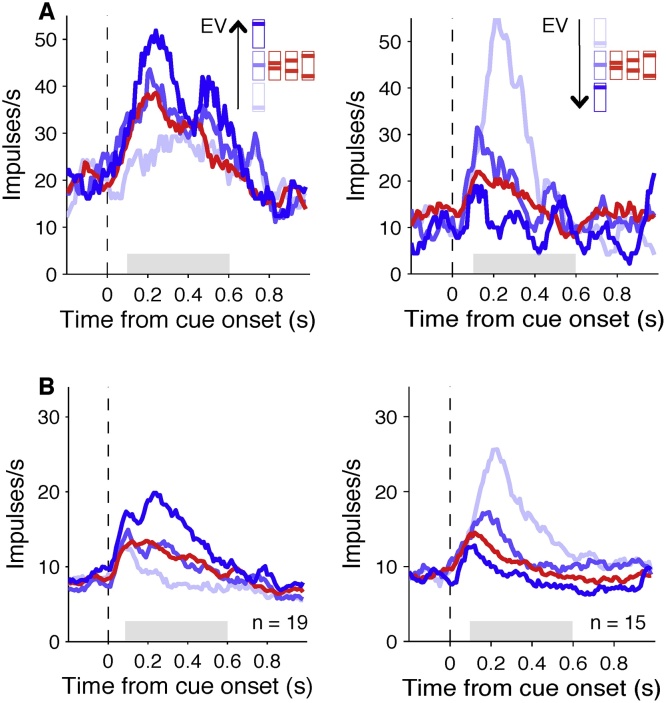
Orbitofrontal neurons code expected value. (A) Smoothed histograms showing examples of individual neurons coding expected value following cue onset with positive slope (left) or negative slope (right). The shaded area shows the time window used for analysis. (B) Smoothed histograms showing population responses from all neurons with statistically significant correlation coefficients for expected value during the shaded period. Risk cues with equal expected value are shown in red, and value cues with no risk are shown in blue. Colour coding of the cues in the figure legend are for presentation purposes only (For interpretation of the references to colour in this figure legend, the reader is referred to the web version of this article).